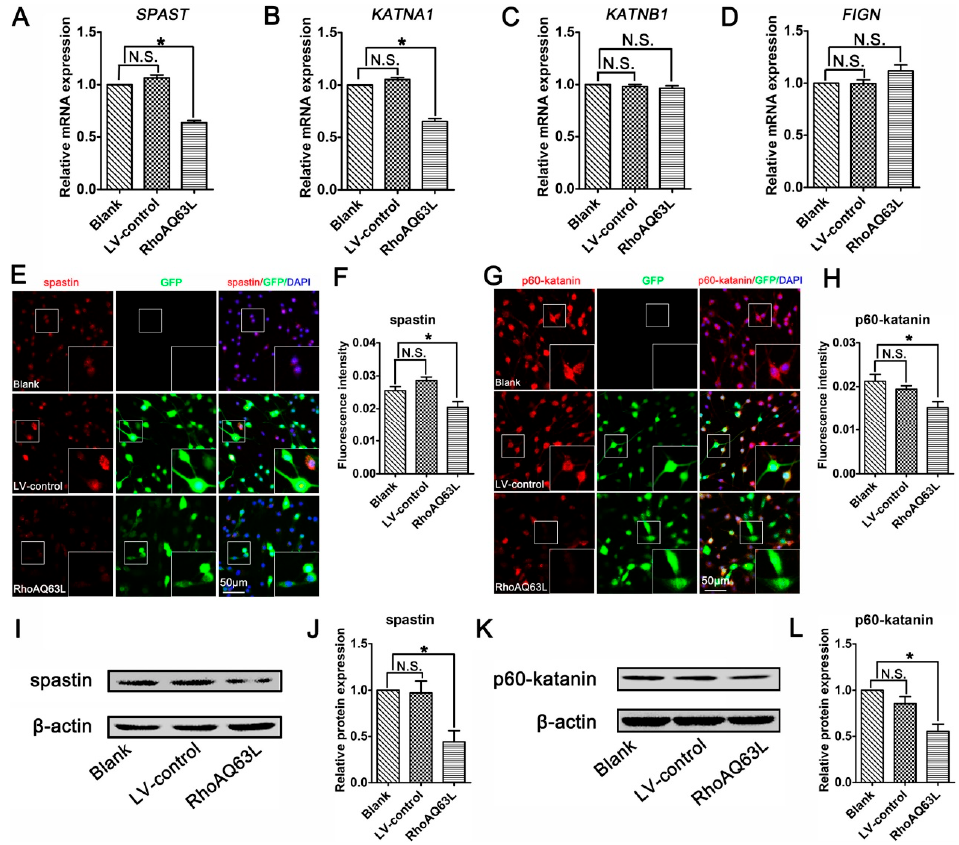
Figure 5. RhoAQ63L transfection decreases the expression of spastin and p60-katanin. ( A – D ) Quantitative RT-PCR indicated that the mRNA levels of SPAST and KATNA1 were significantly decreased in the RhoAQ63L group compared with that in the Blank and LV-control groups, while the mRNA levels of KATNB1 and FIGN were not statistically different between groups. ( E – H ) Immunocytochemistry revealed that the spastin and p60-katanin expressions were reduced in RhoAQ63L transfected cells. ( I – L ) Western blotting illustrated that RhoAQ63L transfection downregulated the expression of spastin and p60-katanin proteins. Both the mRNA and protein levels of the target proteins in the control group were normalized to 1. Data are shown as the mean ± SEM values (*indicates p < 0.05, meaning a statistically significant difference, while N.S. indicates nonsignificance).